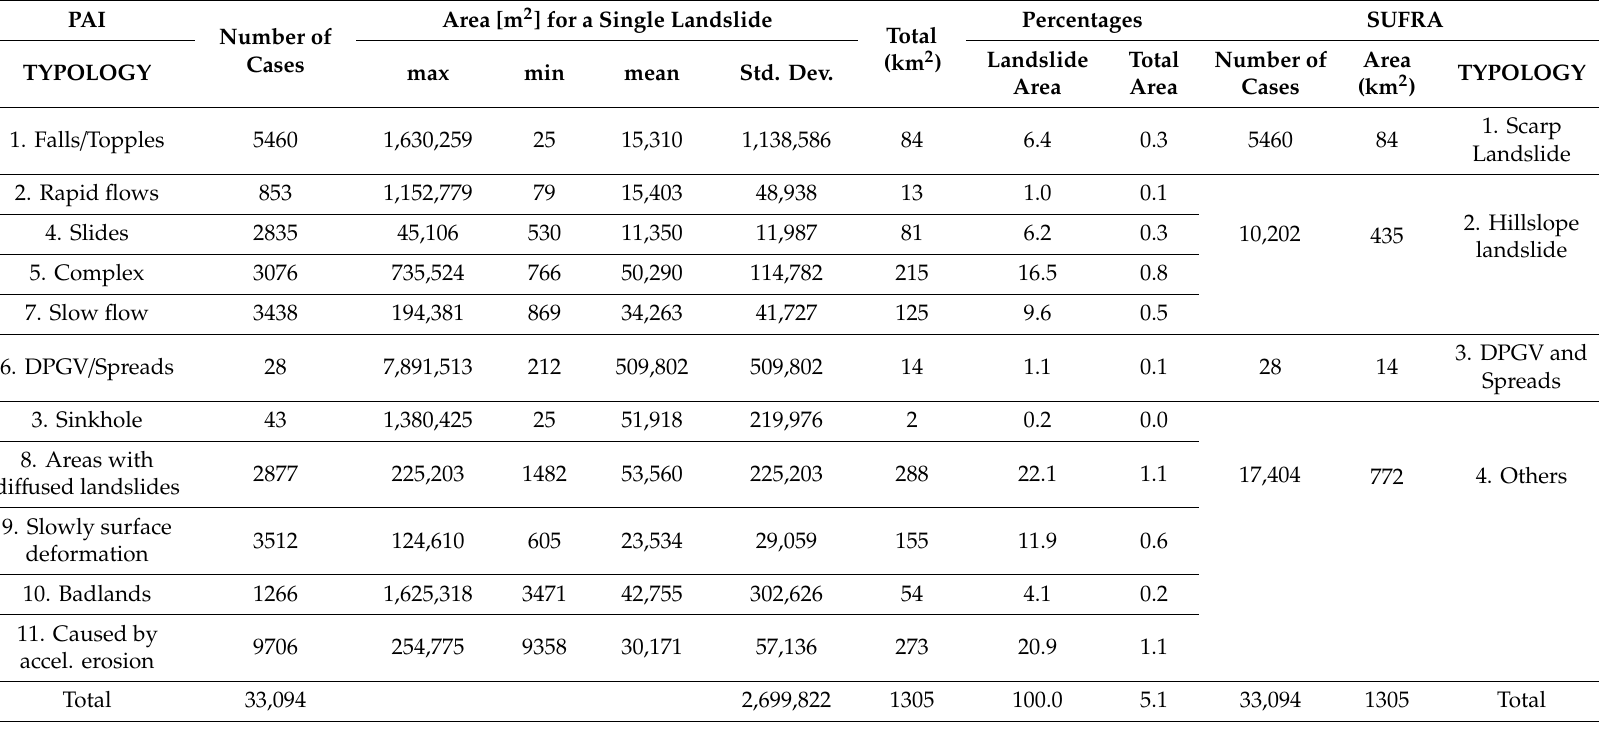
Table 1. Landslide inventory, statistics, and their